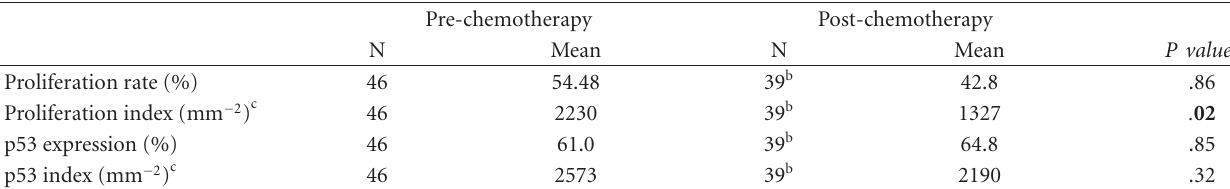
Table 4: The relationships between estimates of tumor cell proliferation and nuclear p53 expression in 46 osteosarcomas, before and after preoperative chemotherapy.